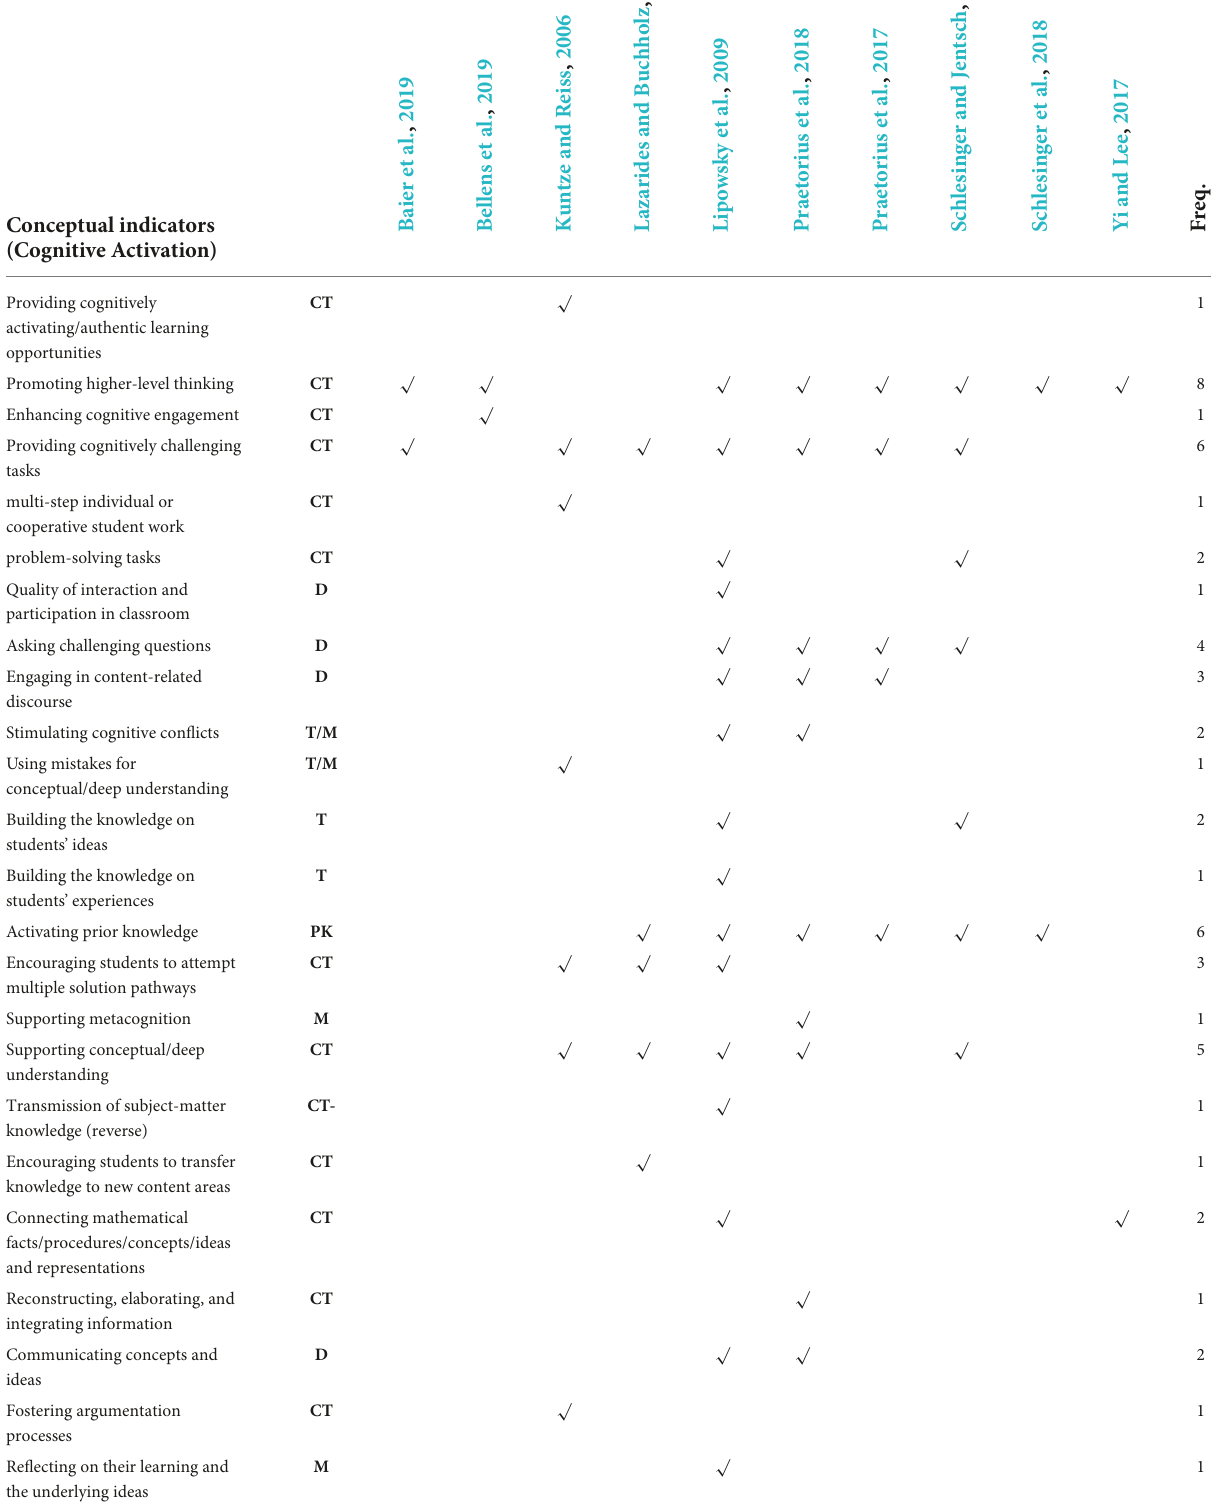
TABLE 5 Overview of conceptual indicators of Cognitive Activation described by various conceptual definitions in previous studies.